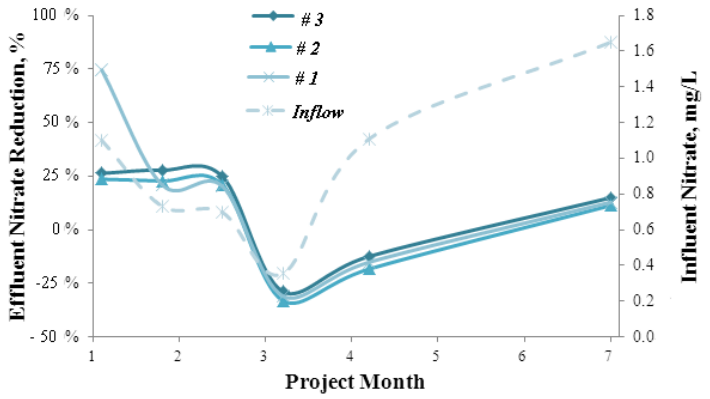
Figure 7. Nitrate-nitrogen (NO 3 -N) removal percentages and inflow NO 3 -N concentrations (mg/L) from May to October 2013.